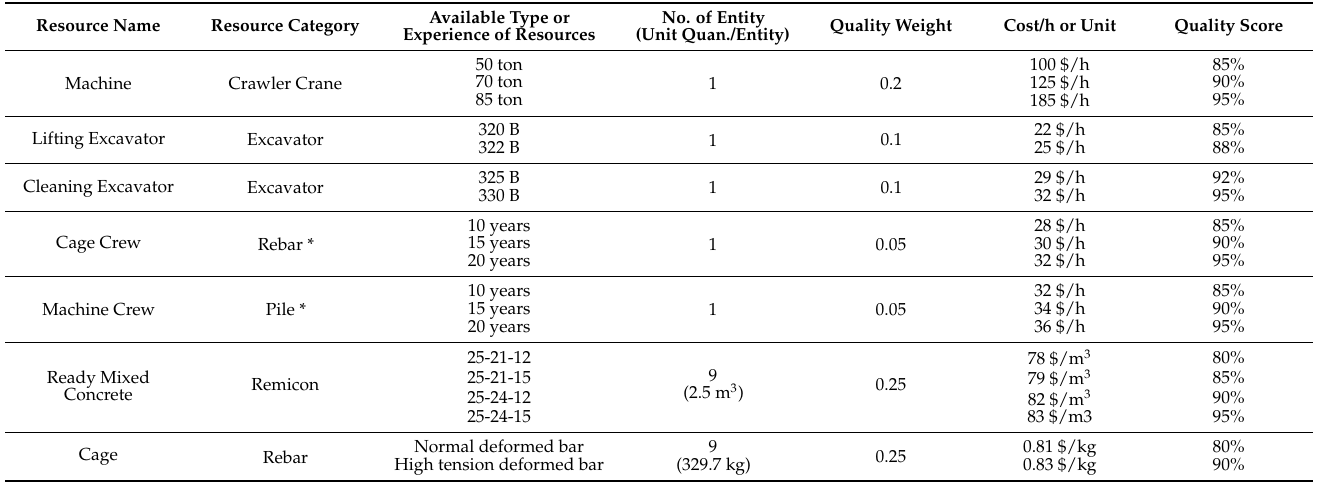
Table 4. Resource